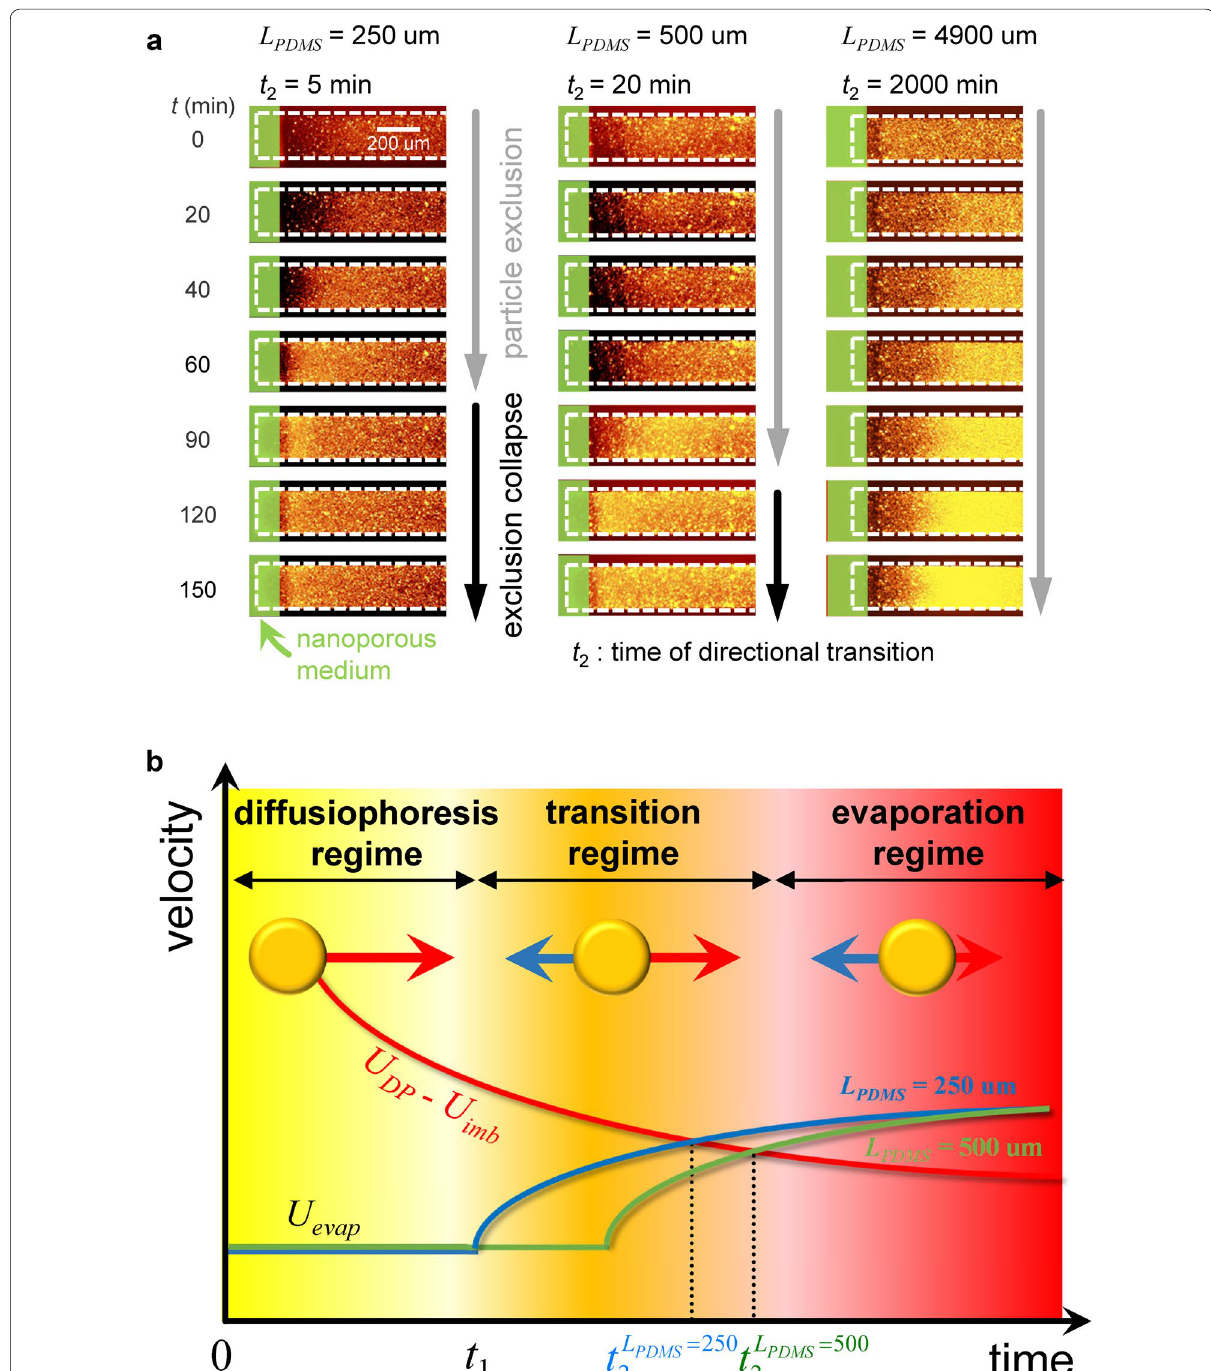
Fig. 3 a Time-evolving images of the particle’s motion depending on L PDMS . b The plot of three regimes about particle’s motion affected by diffusiophoresis, imbibition, and evaporation. t 1 is the time when nanoporous medium was exposed to air (starting time of evaporation). t 2 is the collapse time of spontaneous particle exclusion zone. 0 < t < t 1 is diffusiophoresis dominant regime, t 1 < t < t 2 is transition regime, and evaporation regime appears after t